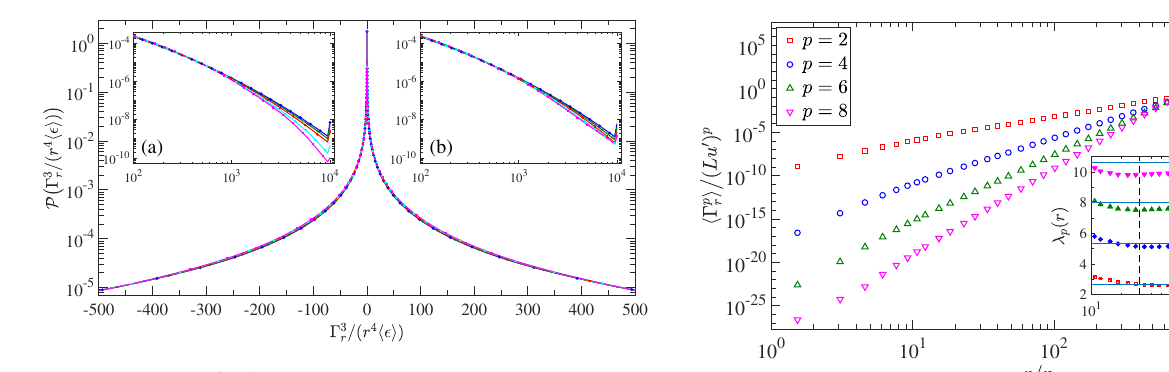
FIG. 5. PDF of Γ 3 r =r 4 h ϵ i at R λ ¼ 1300 at different inertial range separations, r= η ¼ 80 (circle), r= η ¼ 120 (times), r= η ¼ 171 (plus), r= η ¼ 246 (asterisk), and r= η ¼ 300 (square). Insets (a) and (b) show portions of the PDF corresponding to negative and positive Γ r , respectively, on log-log scales. The PDFs nearly collapse across the inertial range separations. If they are exam- ined on an expanded scale, some modest differences are seen around Γ 3 r =r 4 h ϵ i ¼ (cid:2) 150 . Differences occur also towards the tails, as shown in the insets. The tails of each of the PDFs can be fitted by stretched exponentials with unequal stretching factors for the negative and positive tails. For the average curves, the negative part decays with a stretch factor of about 0.35, about twice as large as that for the positive ( ≈ 0 . 17 ).